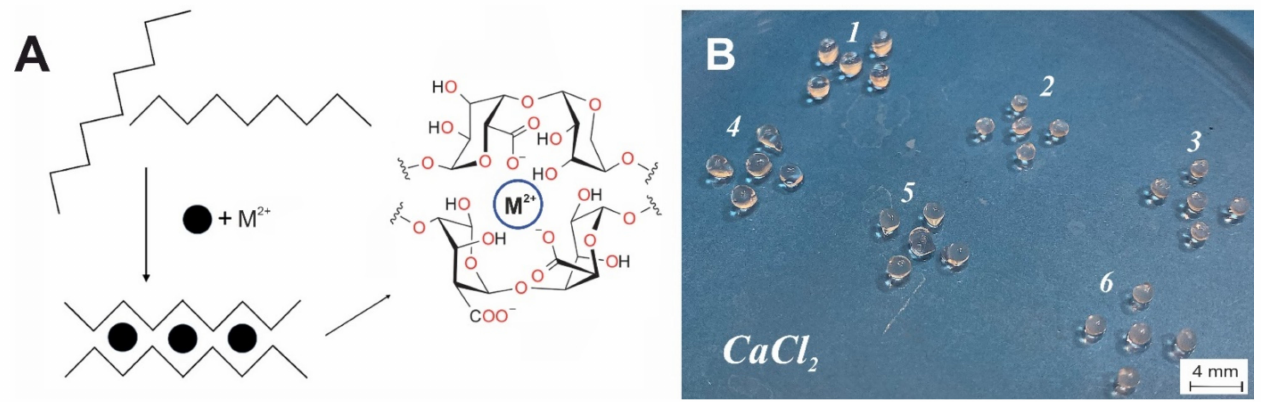
Figure 1. ( A )—schematic illustration of alginate-based formation according to egg-box model; ( B )—pure alginate microspheres (1–3) and CNT-modified ones (4–6) stabilized by Ca 2+ .